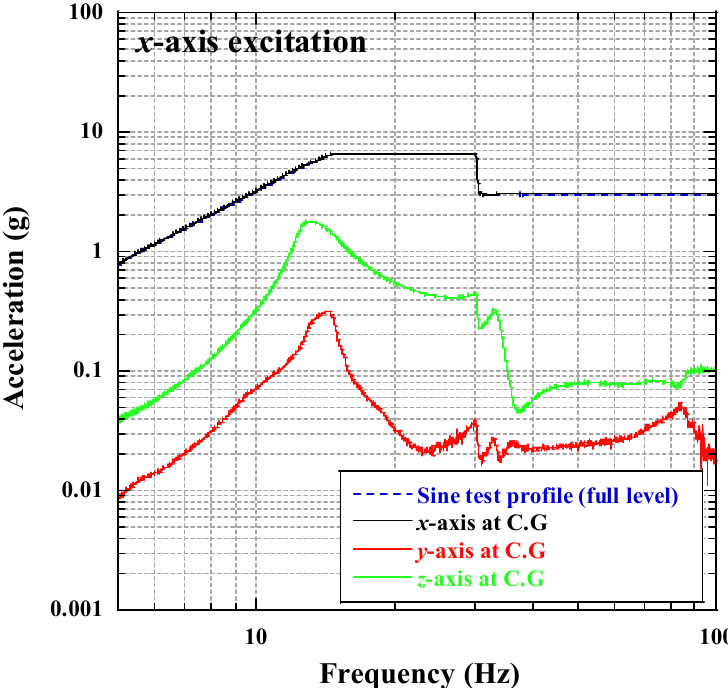
Figure 9. Sine vibration test results of TMCM in x ‐ axis.